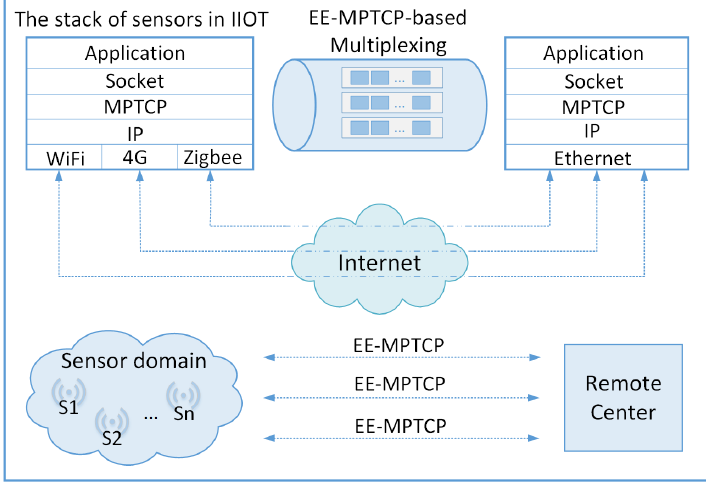
Figure 10. An application example of the EE-MPTCP in